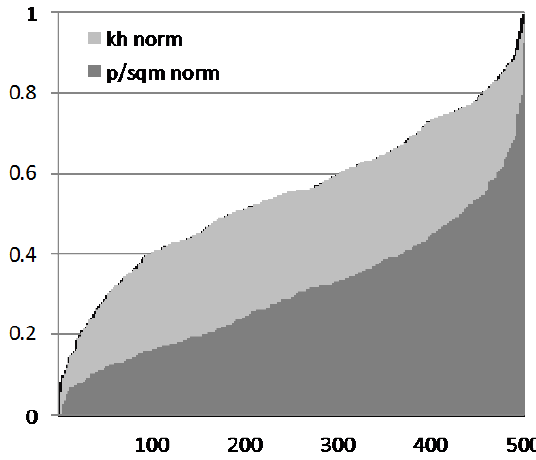
Figure 6. Normalised overall quality k* and normalised unit price of the sample (500 data points).